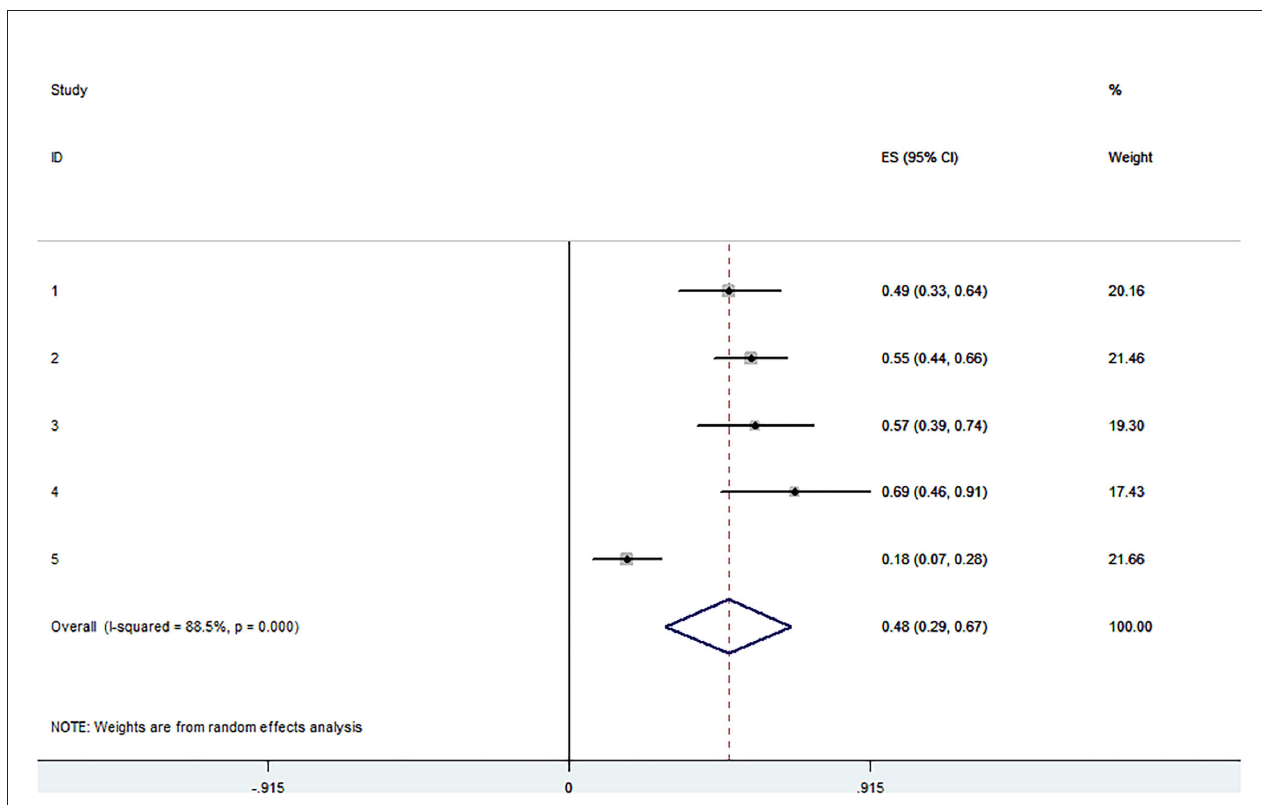
FIGURE 2 | Forest plot presenting the meta-analysis of application rate of type A. CI, Confidence intervals; ES, Effect